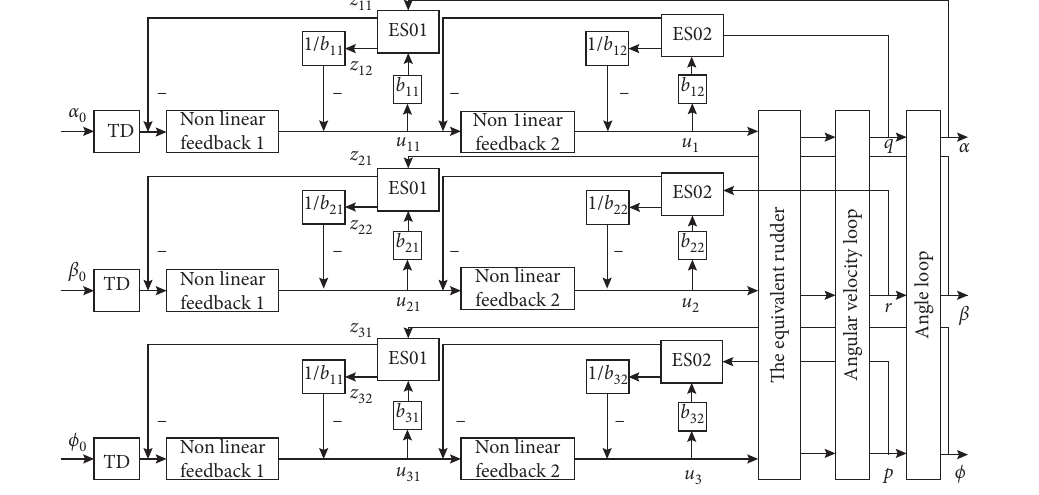
Figure 2: Cascade ADRC structure.